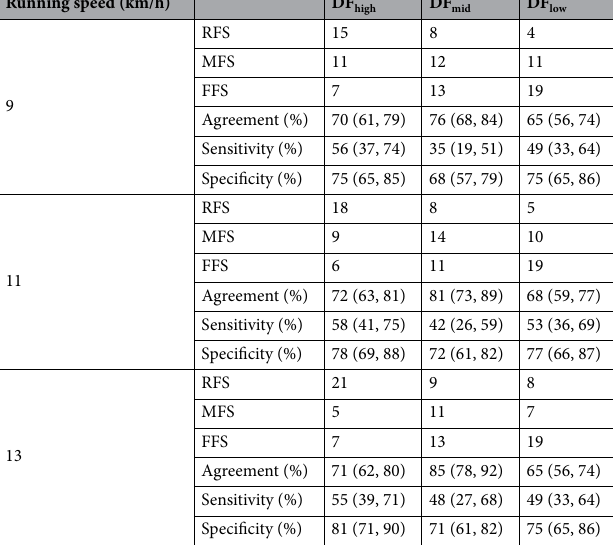
Table 2. Number of runners in foot-strike pattern (FSP) [rearfoot (RFS), midfoot (MFS), and forefoot (FFS) strikers] and duty factor (DF) [high (DF high ), mid (DF mid ), and low (DF low ) DF runners] groups, as well as the agreement, sensitivity, and specificity between FSP and DF groups together with their 95% confidence intervals in parentheses (lower, upper) at three running